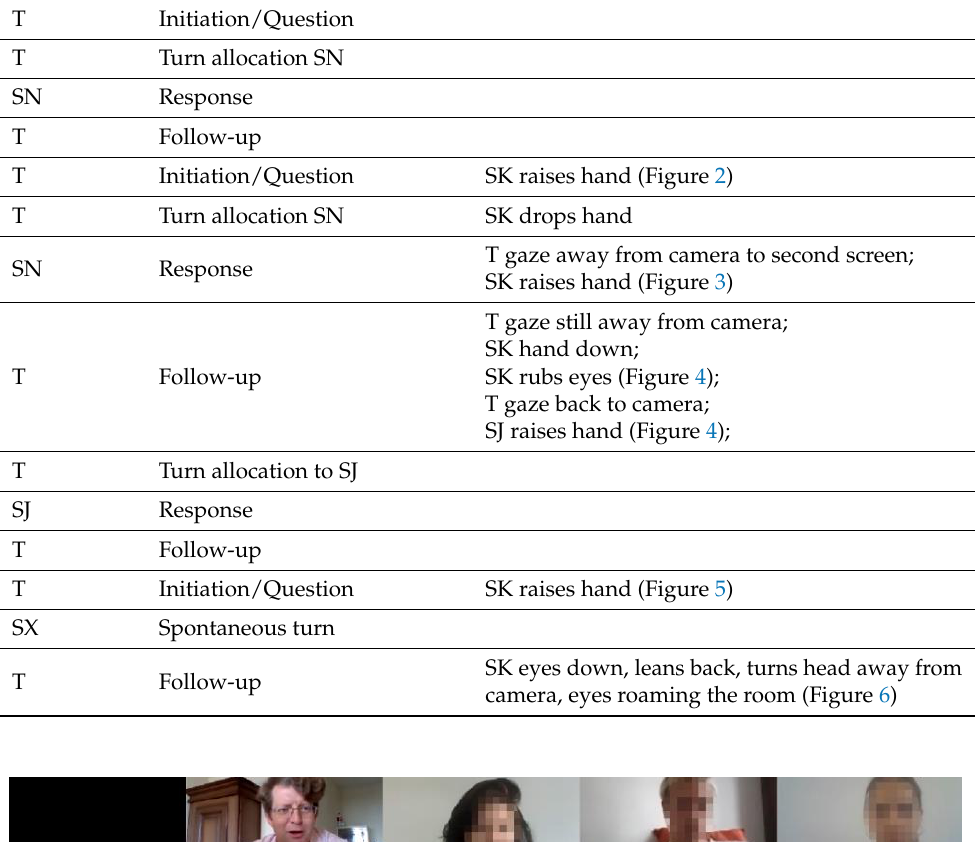
Table 1. Schematic representation of participant moves.